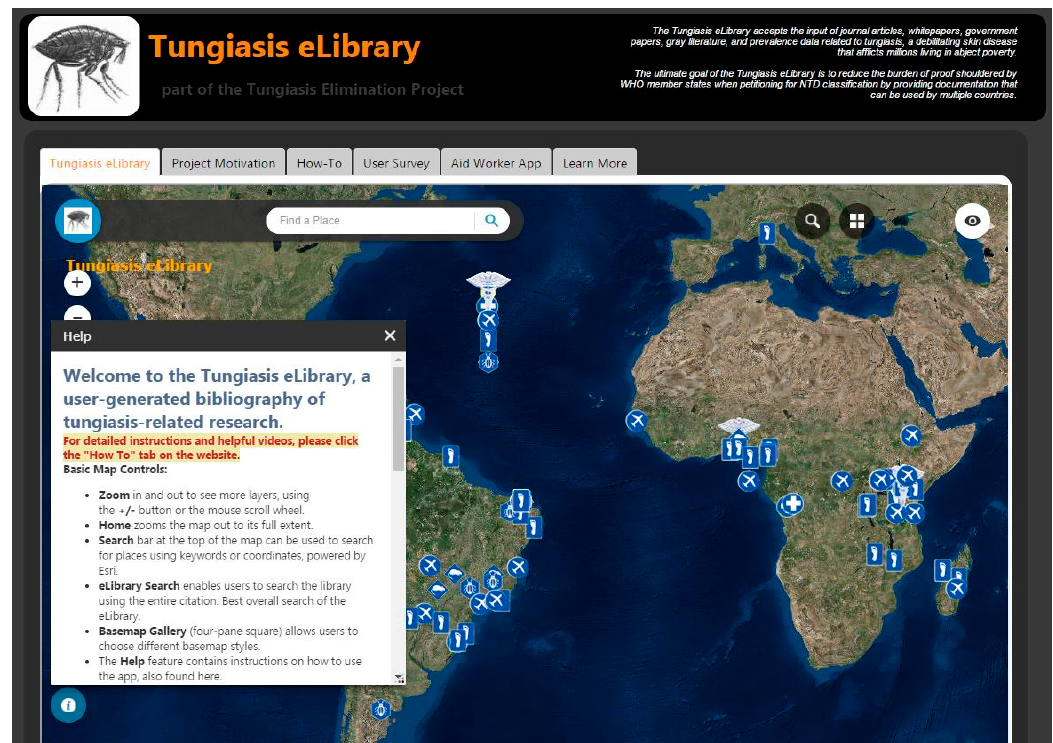
Figure 2. Screenshot of the Tungiasis eLibrary Application website.